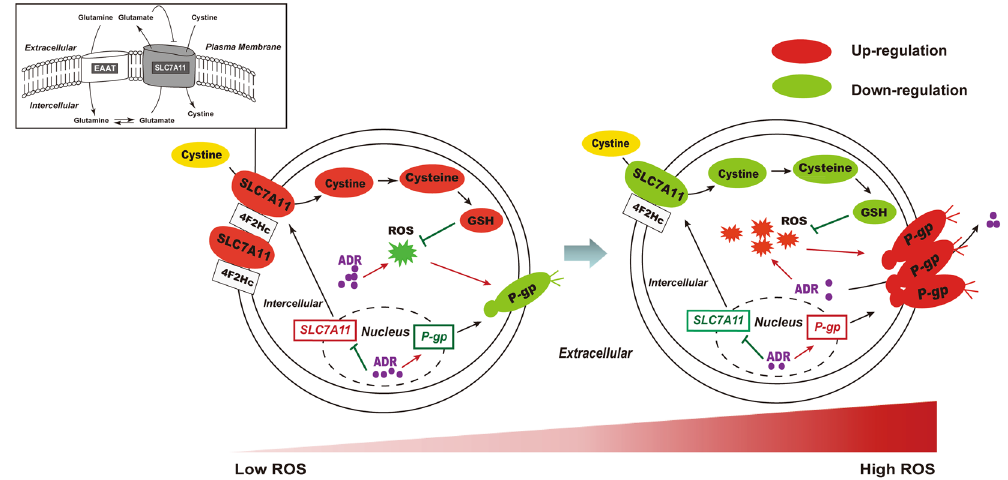
Figure 7. A schematic diagram of the reprogrammed homeostasis of GSH synthesis and subsequent P-gp expression of MCF-7S into MCF-7R cells, where ROS, SLC7A11 and cystine play an important role in the process. Red indicates up-regulation and green indicates